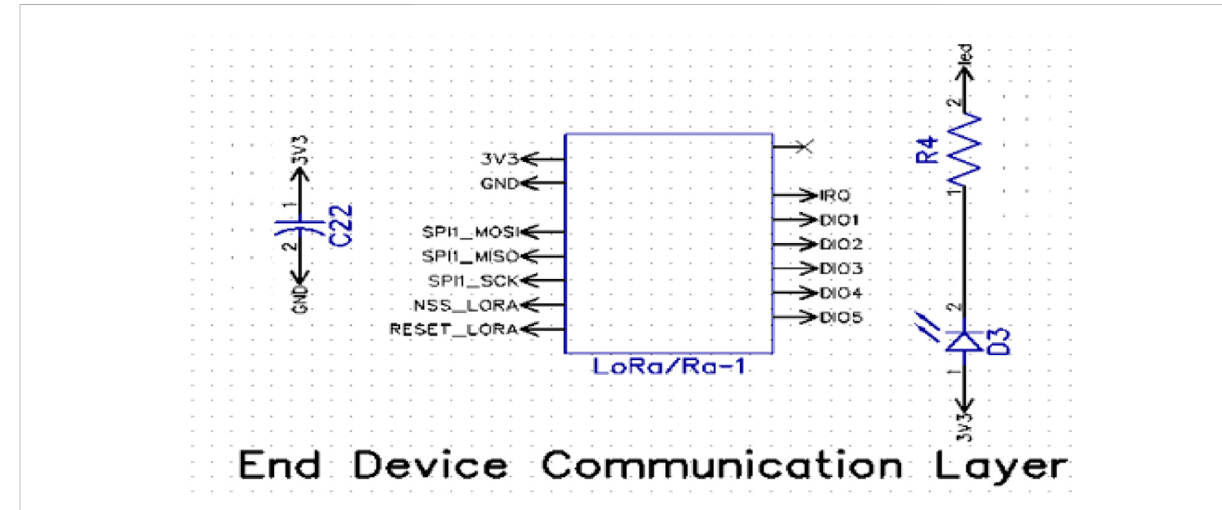
FIGURE 5 Schematic diagram of the end device ’ s communication layer.